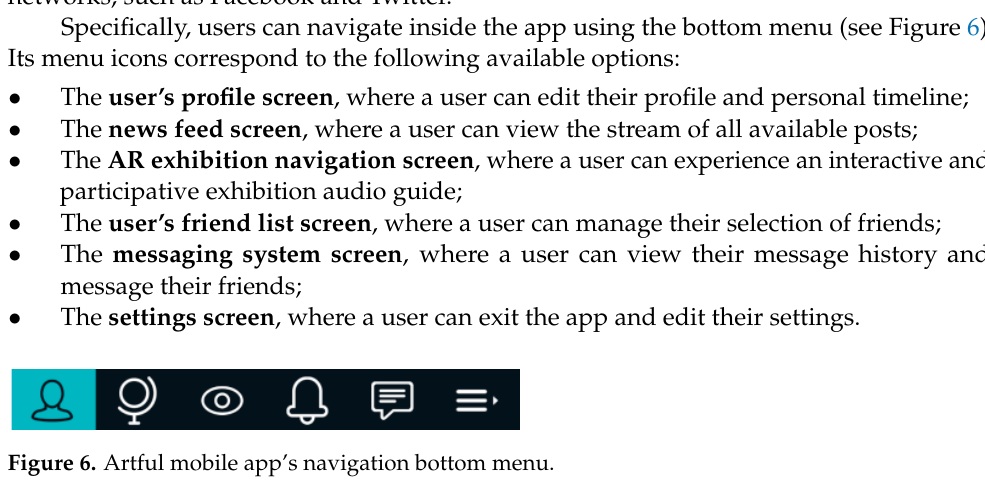
Figure 6. Artful mobile app’s navigation bottom menu.